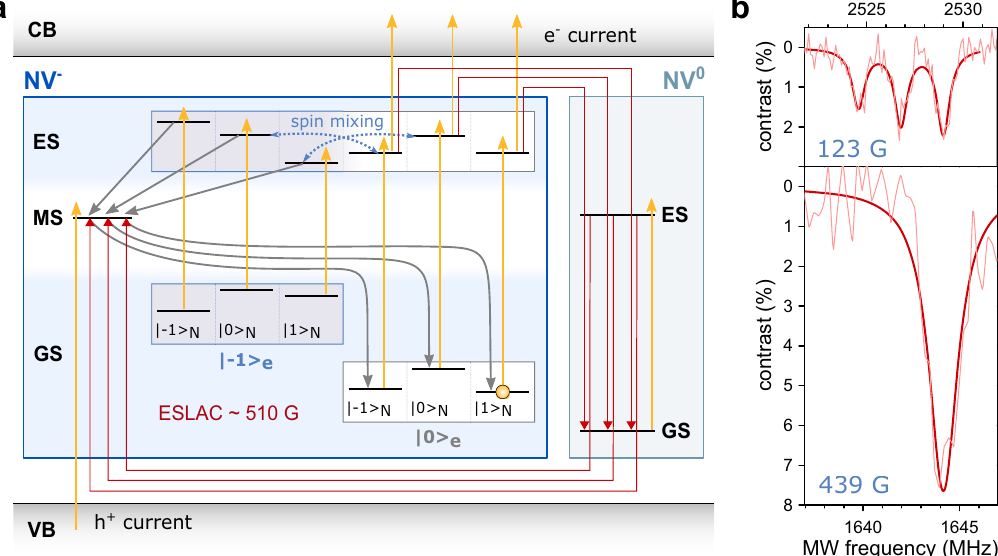
Fig. 2 PDMR detection at ESLAC. a Schematic describing the photoelectric readout principle at ESLAC. Only transitions responsible for the PDMR contrast between the different electron and nuclear spin states are visualized. The |m s 〉 = | + 1 〉 state, which was not probed in these experiments, is omitted for clarity. Under the application of the magnetic fi eld (~510 G for ESLAC), the NV − centre ground state (GS) energy levels |m s 〉 = | − 1 〉 and |m s 〉 = |0 〉 are well separated (~1.5 GHz), whereas the excited state (ES) becomes nearly degenerate resulting in spin mixing between the states with the equivalent total spin projection quantum number. The spin mixing combined with the electron spin polarisation to |m s 〉 = |0 〉 through the metastable state (MS) [grey arrows], results in the spin polarisation to the |m s 〉 = |0 〉 electron and |m I 〉 = | + 1 〉 nuclear spin state. The yellow arrows depict optical transitions induced by the application of the yellow-green laser. As can be seen, the |m s 〉 = |0 〉 spin sublevels in the ES are more likely to be excited by the second photon and contribute to the photocurrent by promoting the NV electron to the diamond conduction band (CB). When this happens, the negatively charged NV − centre is converted to NV 0 centre (red arrows). The back-conversion is possible by another two-photon process while preserving the nuclear spin orientation. First, the NV 0 centre is excited to the ES and subsequently, an electron is promoted from the valence band (VB) to the vacated orbital of NV 0 , leading to the formation of NV − centre. In this process the NV − |m s 〉 = |0 〉 ground states ef fi ciently repolarise. b Pulsed PDMR measurements of the NV nuclear ( 14 N) and electron (m s = − 1) spin hyper fi ne interaction for different magnetic fi elds showing nuclear spin polarisation close to the ESLAC (experimental conditions for measurement at 123 G — 1500 ns laser pulse of 4 mW power, 1100 ns long MW π -pulse; for measurement at 439 G — 1000 ns laser pulse of 6 mW power, 400 ns long MW π